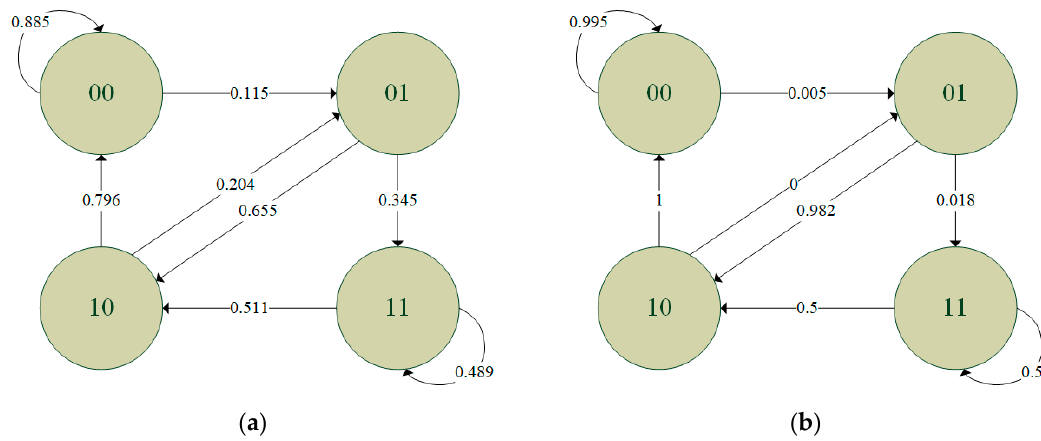
Figure 9. Training results for the two-state Markov model using: ( a ) records in the first minute of the sixth hour, and ( b ) records in the first minute of the tenth hour.